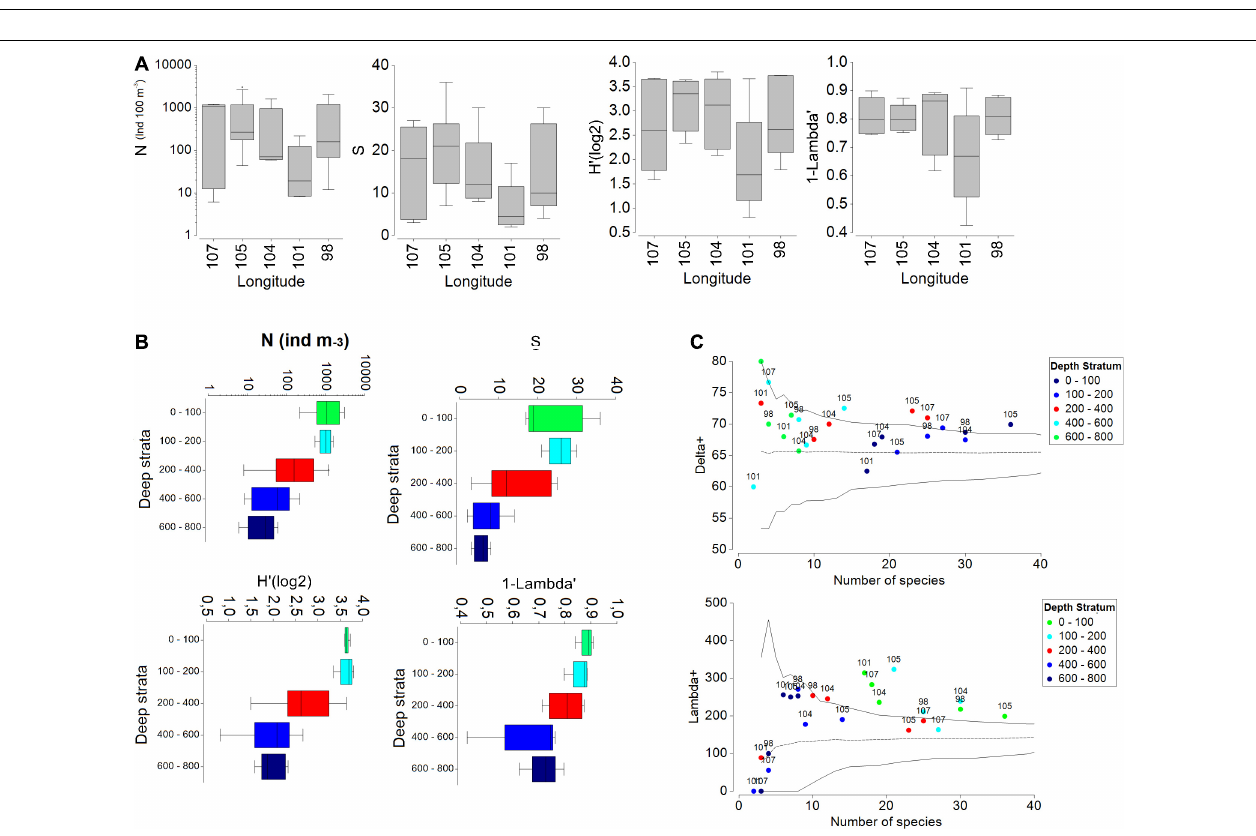
FIGURE 6 | (A) Boxplot of abundance (N, log scale), richness (S) and diversity index (Shannon-Wiener and Simpson) of the copepod community in the Pacific Southeast, Chile, ( ∼ 27 ◦ S) during October and November of 2015 by longitude. (B) Boxplot of the same biological descriptors by depth strata and the boundary of the box indicates the 25th and 75th percentile, the line within the box indicates the median, and the whiskers above and below the box indicate the 90th and 10th percentile. (C) Average taxonomic distinction index (delta+) and average taxonomic variation index (lambda+) for the copepod community in the SPSG. The central line shows the mean, while the continuous lines are the distribution of probability at 95%.